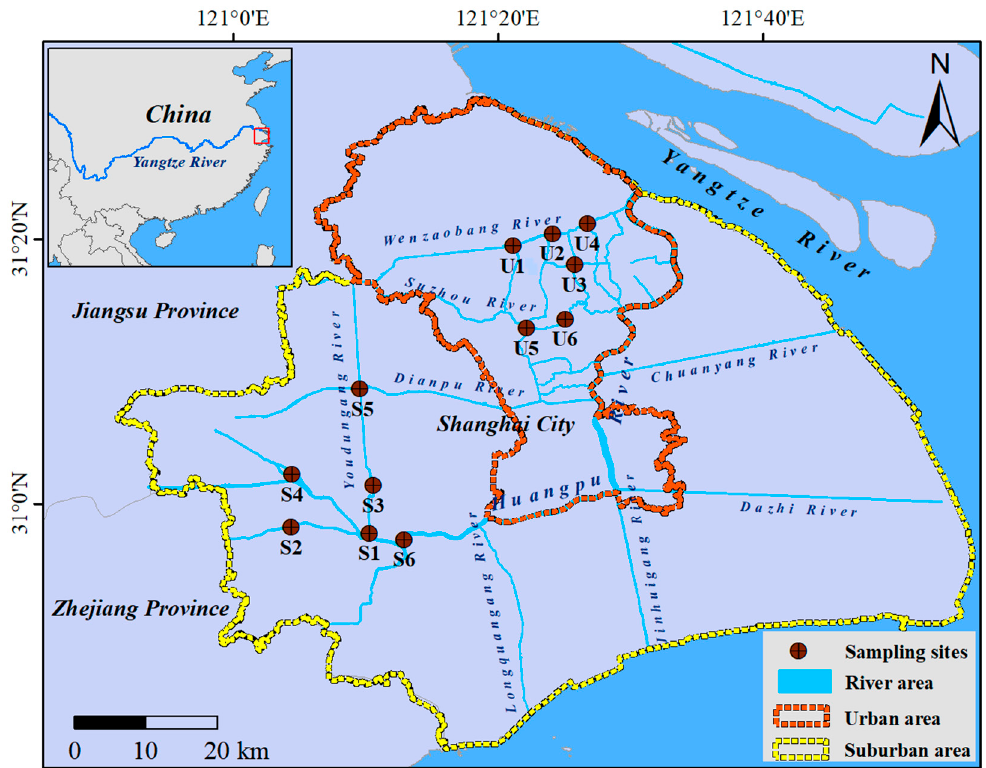
Figure 1. The sampling sites were located at the urban rivers (U1–U6) and suburban rivers (S1–S6) of the highly urbanized city (Shanghai, China).